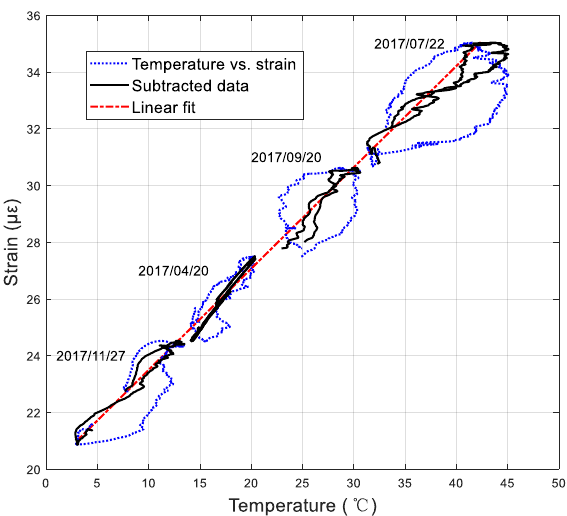
Figure 10. Temperature – strain curve and the subtracted data curve in different seasons.